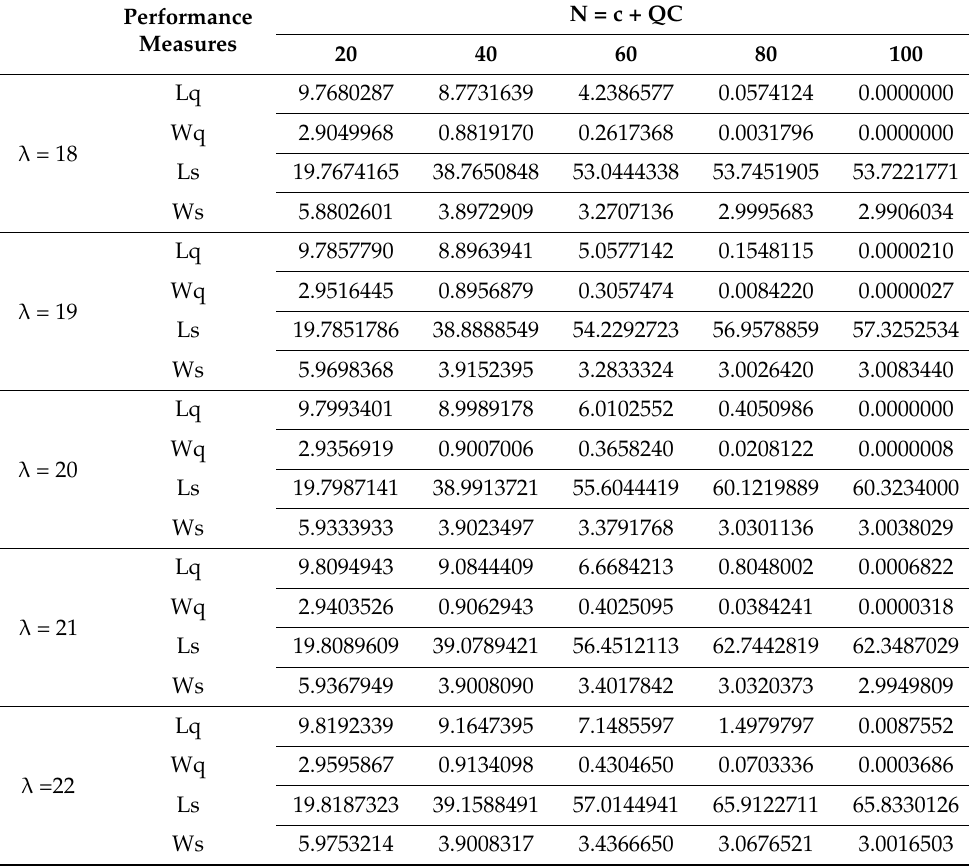
Table 11. The effect of variation of parameter λ on performance measures, expected number of customers in system (Ls), expected number of customers in queue (Lq), expected waiting time in system (Ws), and expected waiting time in queue